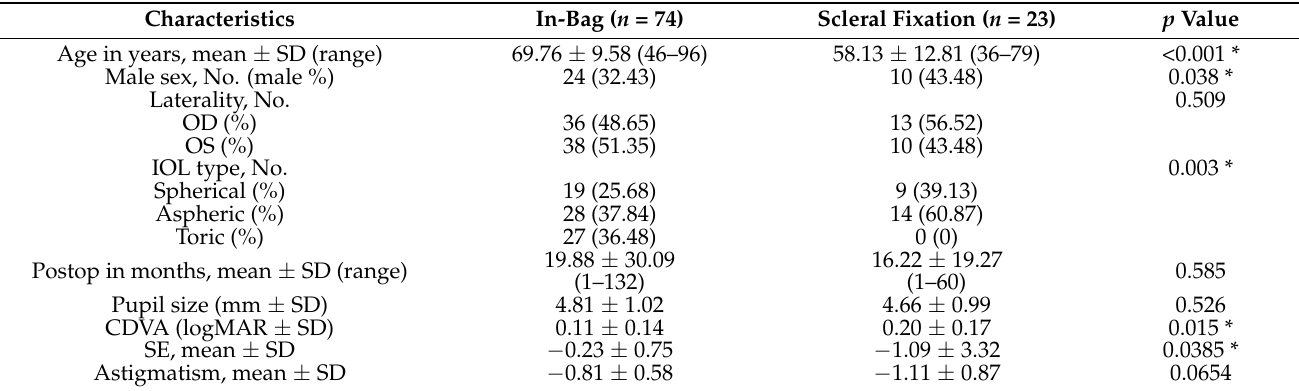
Table 1. Demographics and visual outcomes of eyes following in-bag and scleral-fixated intraocular lens implantation.